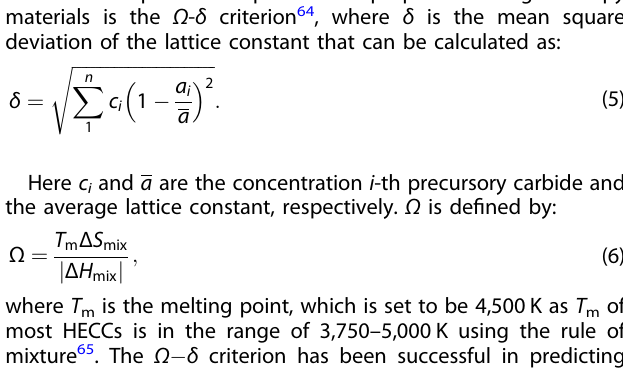
ffiffiffiffiffiffiffiffiffiffiffiffiffiffiffiffiffiffiffiffiffiffiffiffiffiffiffiffiffiffiffi X n